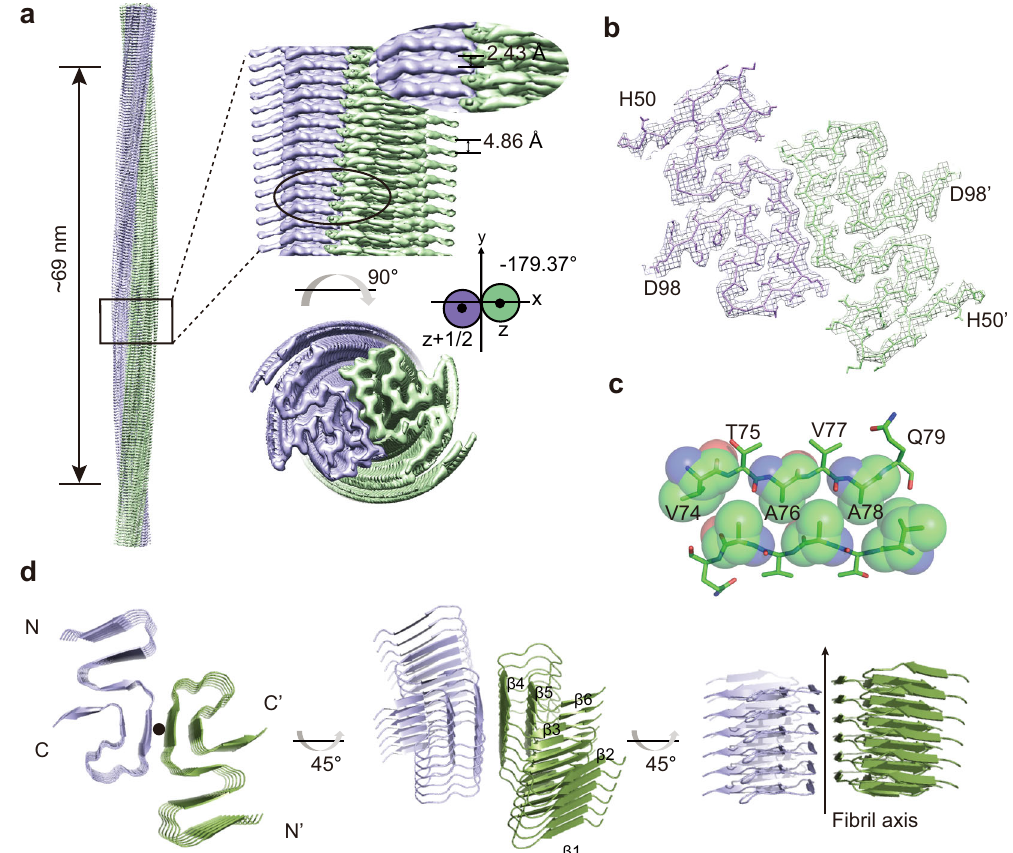
Fig. 2 Cryo-EM structure of the G51D α -syn fi bril. a Cryo-EM density map of G51D α -syn fi bril. Fibril parameters including half-pitch, twist angle, and rise are marked. The two proto fi laments are colored in medium purple and forest green, respectively. The map was prepared by UCSF Chimera v1.13. b Cross- section view of the density map with a built-in structure model. c The proto fi lament interface of G51D fi bril is shown in sticks. Residues involved in the inter-proto fi lament interactions are indicated in spheres. d Views of six layers of G51D α -syn fi brils are shown in the cartoon. The fi bril axis is indicated. The β -strands are numbered and labeled